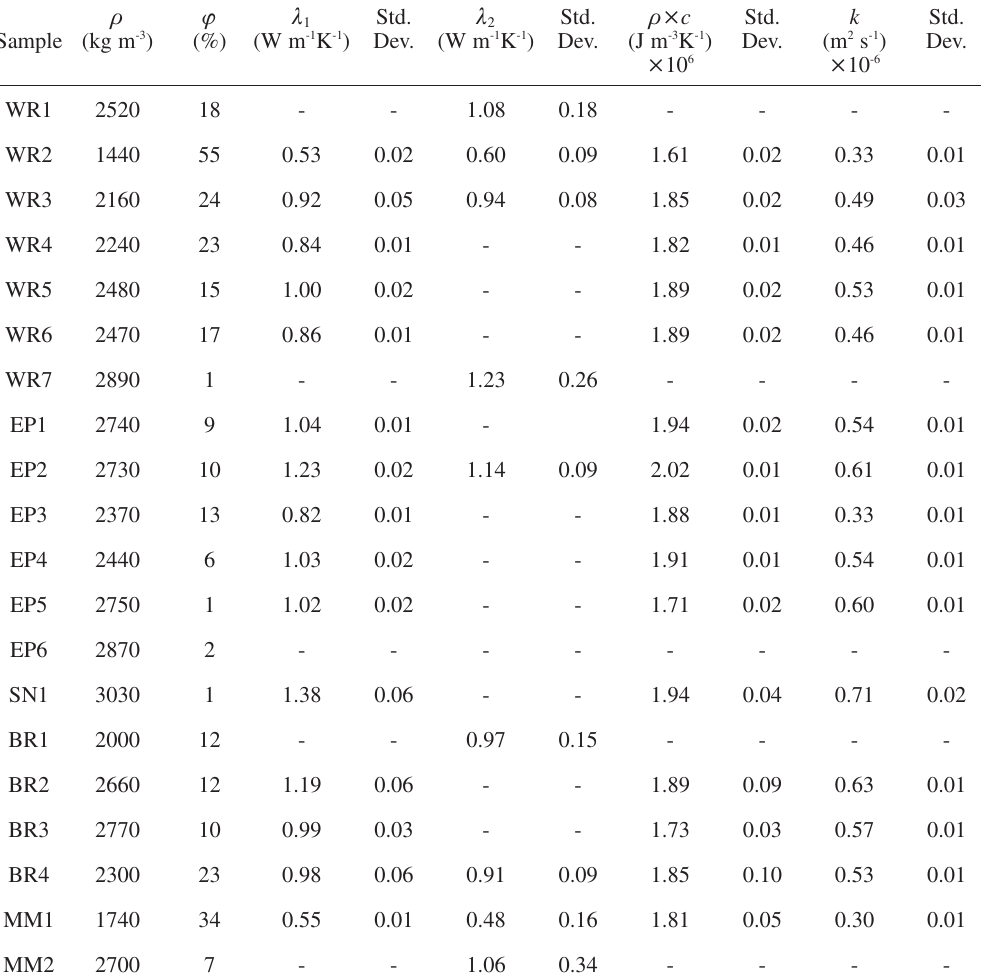
Table II. Bulk density ( ρ ), porosity ( σ ), thermal conductivity ( λ 1 by ISOMET, λ 2 by PRC), volumetric heat ca- pacity ( ρ× c ) and thermal diffusivity ( k ). ρ ϕ λ λ ρ× c 1 Std. 2 Std.